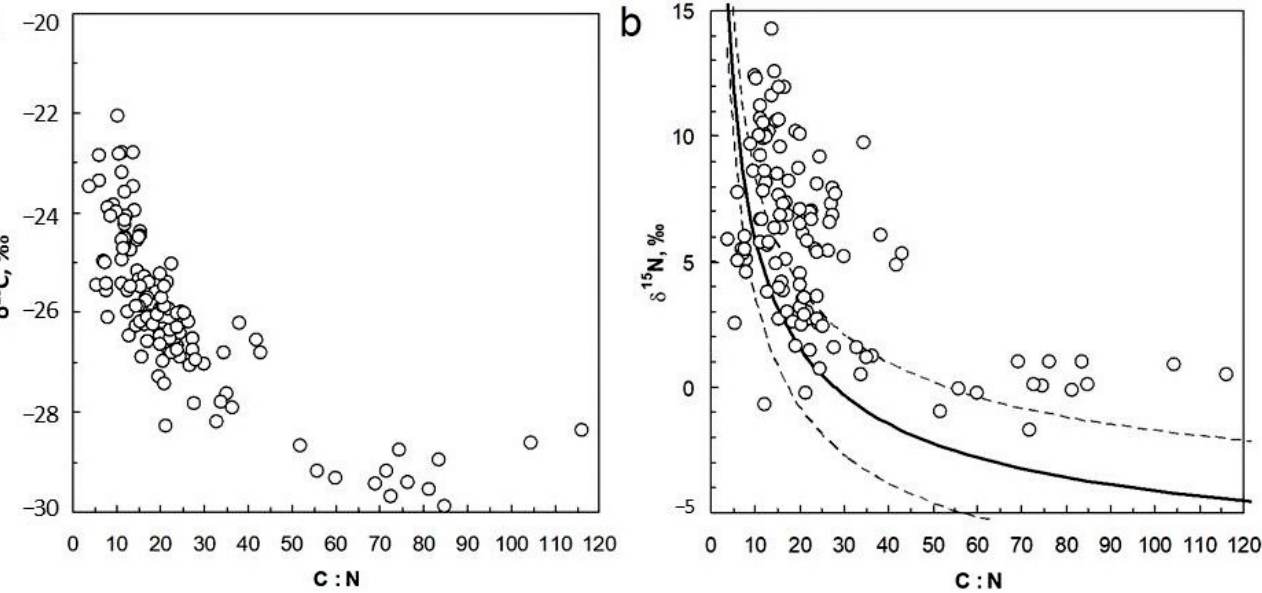
Figure 4. Relationships between C:N ratio and δ 13 C -SOC ( a ) and δ 15 N ( b ) in soils (O, E pyr , E, Bs, B horizons) developed under pine forests of Central Siberia affected by wildfires 1–121 years ago. In the figure b, the bold continuous line is a function fitted to the unperturbed soil samples and dashed lines are the range ±2.4‰ as given in Connen et al. 2013 [48] .